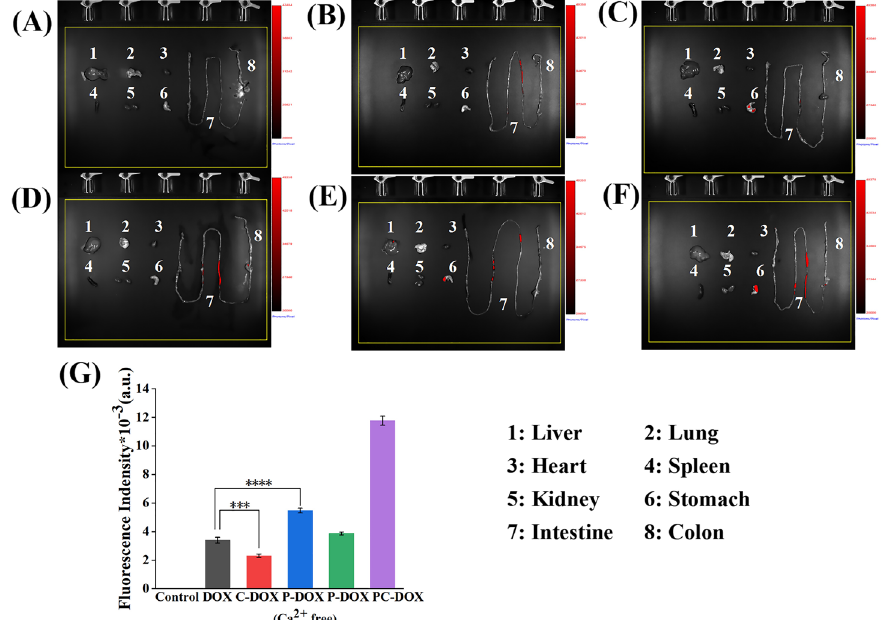
Figure 4. The organs of different groups: 1: liver, 2: lung, 3: heart, 4: spleen, 5: kidney, 6: stomach, 7: intestine, 8: colon. ( A ) Pectin − Ca 2+ gels for the control group, ( B ) free DOX group, ( C ) C − DOX group, ( D ) P − DOX (Ca 2+ free) group, (E) P − DOX group, and ( F ) PC−DOX group were pictured by the Small Animal Live Imaging System. ( G ) Summary of fluorescence intensity for each group ***p<0.001, ****p<0.0001( n =3). PC−DOX had the highest fluorescence content in all of the groups, which means the PC−DOX had an excellent ability to locate the colon.